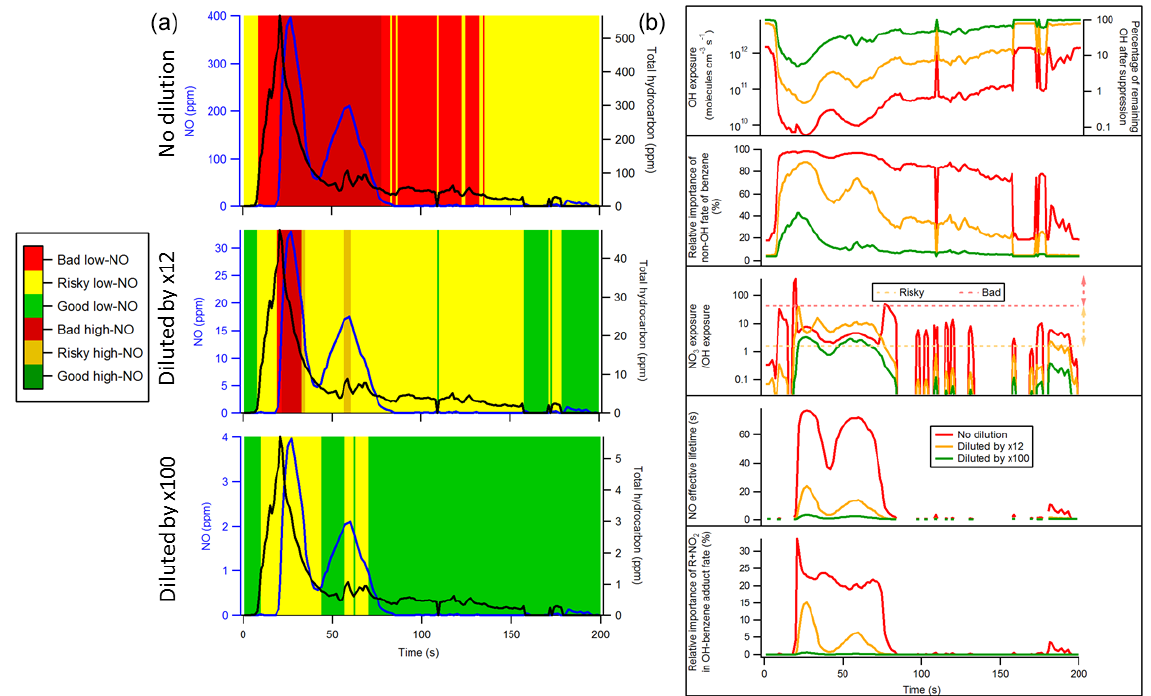
Figure 7. (a) NO and total hydrocarbon during the first 200s of the test of Karjalainen et al. (2016) in the cases of no dilution, dilution by a factor of 12 (as actually done in that study), and dilution by a factor of 100. Different periods of time are colored according to corresponding emissions (i.e., input conditions for OFR) classified as good/risky/bad high-/low-NO emissions. (b) OH exposure and percentage of remaining OH after suppression, relative importance of non-OH fate of benzene, exposure ratio of NO 3 to OH, NO effective lifetime, and relative importance of reaction of OH–toluene adduct with NO 2 in the fate of this adduct in the OFR of Karjalainen et al. (2016) during the first 200s of their test in the cases of no dilution, dilution by a factor of 12, and dilution by a factor of 100. Horizontal orange and red dashed lines in the middle right panel denote “risky” and “bad” regions for exposure ratio of NO 3 to OH, respectively. Above the orange (red) dashed line, reaction with NO 3 contributes > 20% to the fate of phenol (isoprene).